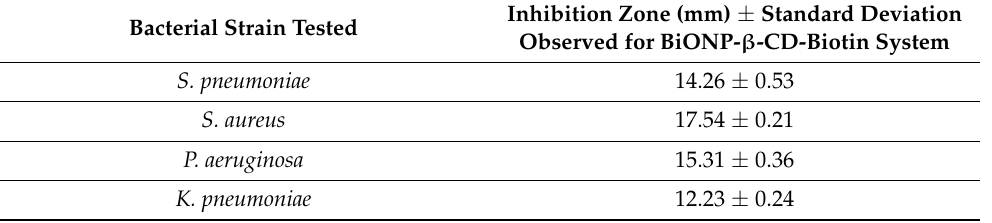
Table 1. Result of the diameter of the inhibition zone observed for BiONP- β -CD-Biotin system against bacteria.